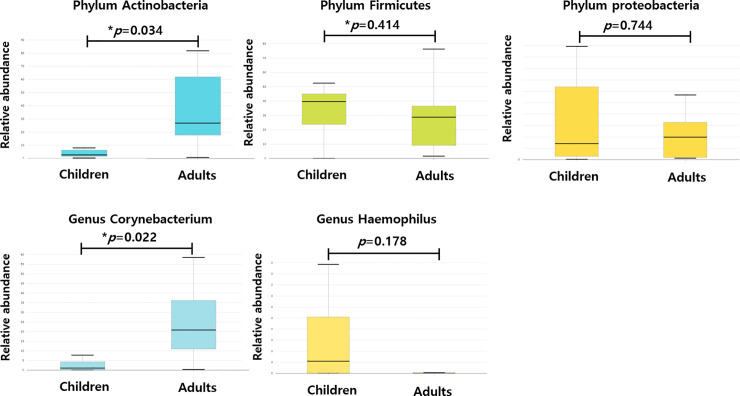
Bacterial species that discriminate between adult and pediatric CRS patients.Discriminative species that were different between the two groups were Actinobacteria at the phylum level, Corynebacterium at the genus level. *p < 0.05.